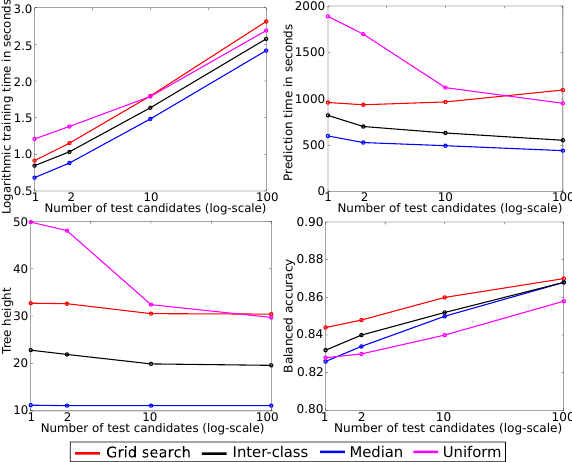
Figure 4. Influence on computation time, tree topology, and accuracy by optimized test